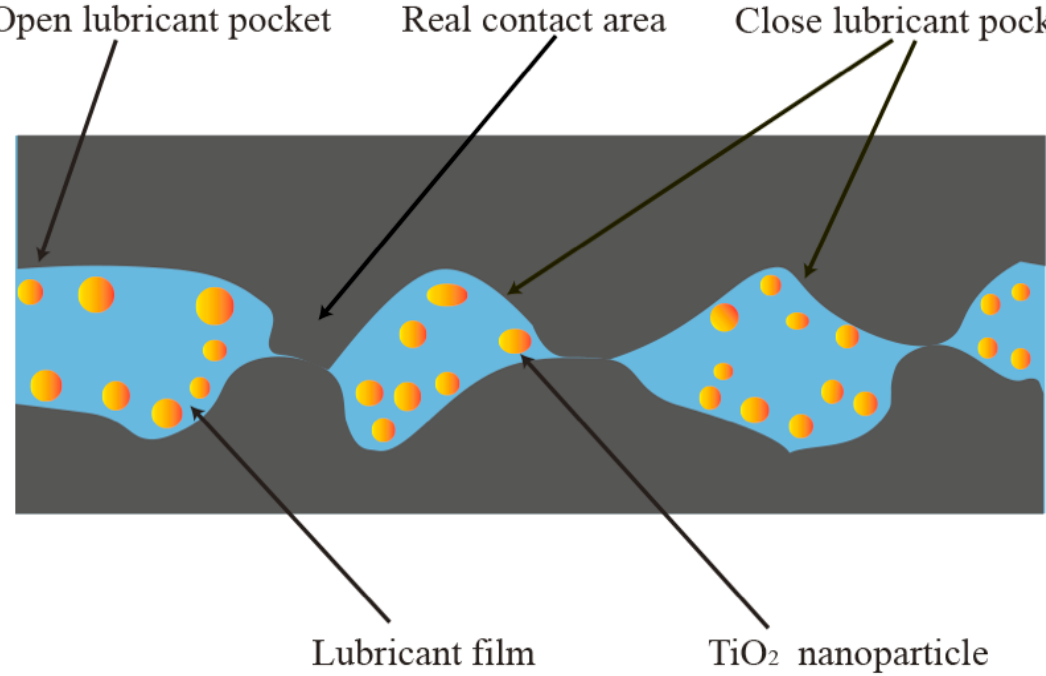
Figure 13. The schematic of the lubrication mechanism of TiO 2 nanolubricant.